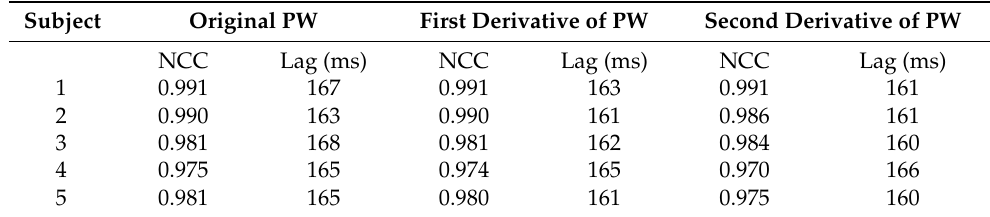
Table 4. Normalized cross-correlations and time lags between whole PW signals acquired by FCG and PPG-R